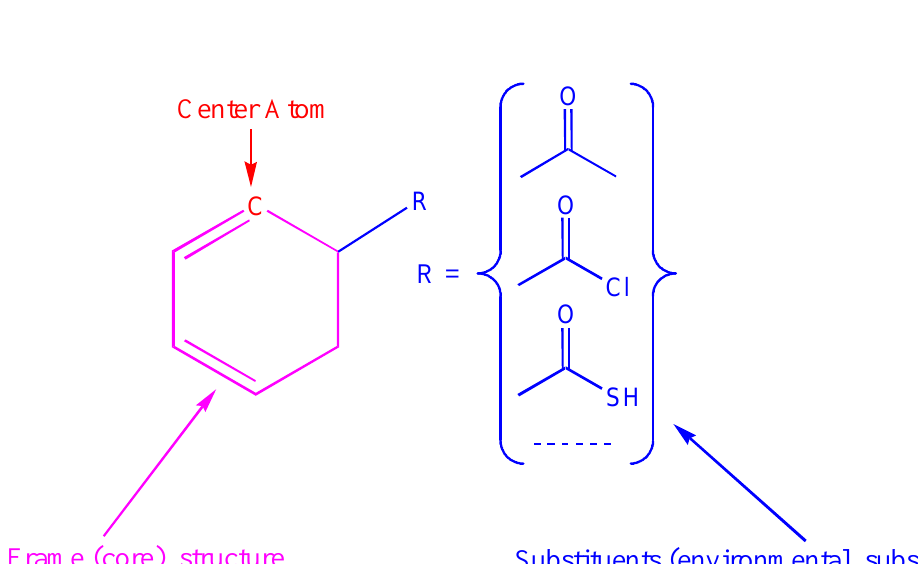
Figure 5. Center atom, core structure and environmental